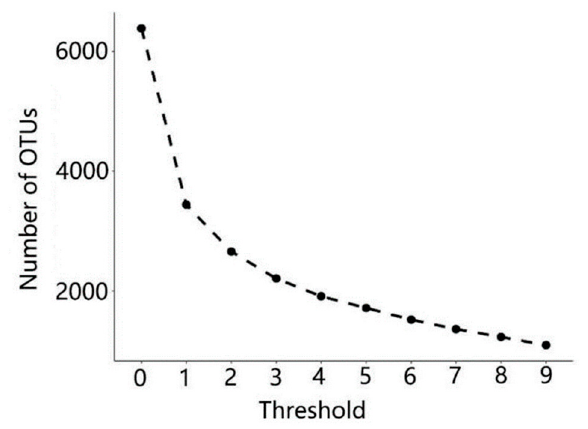
Figure 1. The number of operational taxonomic units (OTUs) under different filtering strategies. Threshold is the minimum number of sequences belonging to a single OTU. Table 1. Statistics of MiSeq sequencing of 16S rRNA. VF: virgin field, WH: wellhead, ST: storage tank.